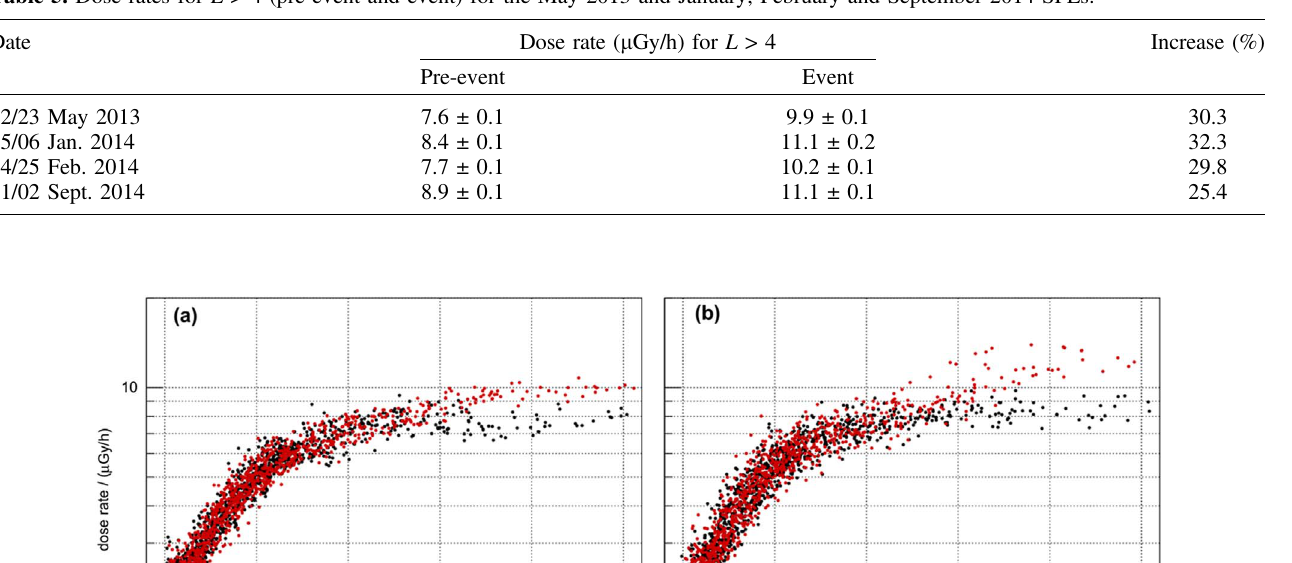
Table 5. Dose rates for L > 4 (pre-event and event) for the May 2013 and January, February and September 2014